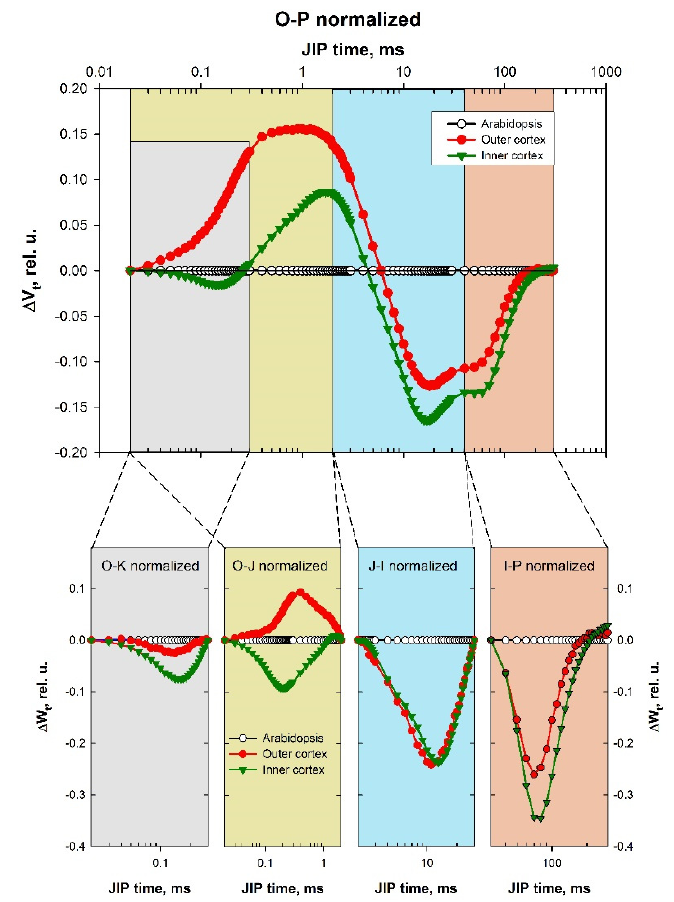
Figure 4. Difference curves showing differences in IC of PF between the gall cortex (inner or outer) and the reference plants A. thaliana . Each DC value was calculated as a difference between the values of the relative variable fluorescence [V t = (F t − F O )/(F M − F O )] in the gall cortex minus the respective values for the leaves of the reference plants A. thaliana [ ∆ V t = V t(cortex) − Vt ( A. thaliana ) ]. The four characteristic bands are marked with different colors (A). The four lower panels (B–E) represent the difference curves calculated for each band separately ( ∆ W t ). The equations for the calculations of the respective ∆ W t are presented in Materials and Methods.